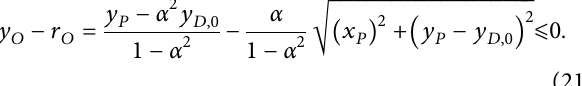
Figure 5: The shortest path between a point outside and a point on the circle without penetrating